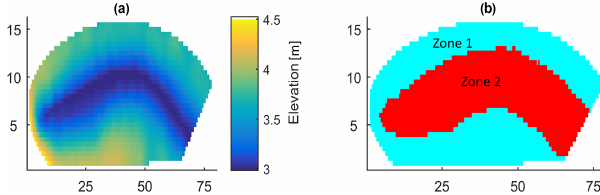
Figure 9. (a) The digital elevation model of Borden catchment and (b) zoning map of the catchment based on depth to water table less than 1.5m (red) and greater than 1.5m (blue).